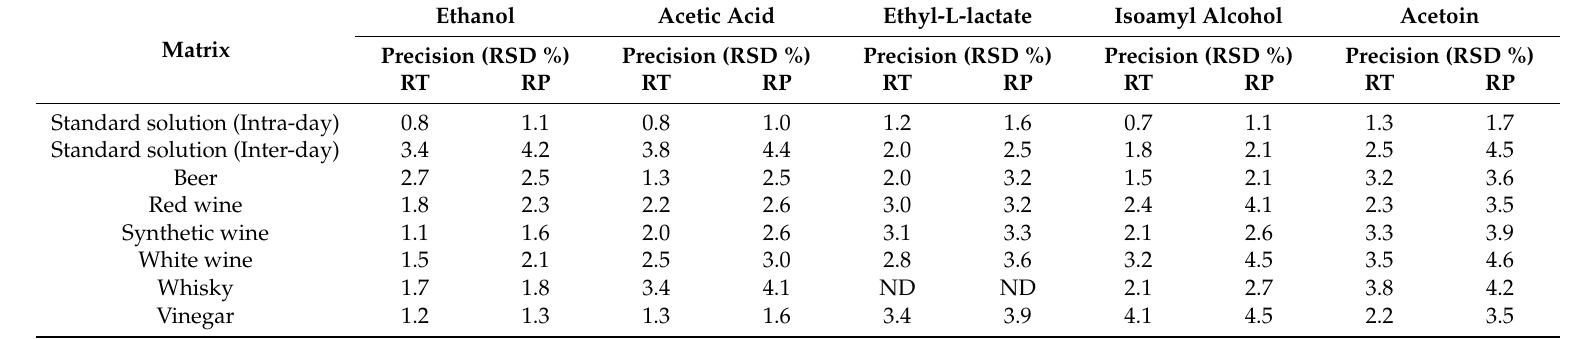
Table 2. The precision of quantification of major fermentation end products using gas chromatography-mass spectrometry (GC-MS) analysis in different matrices.